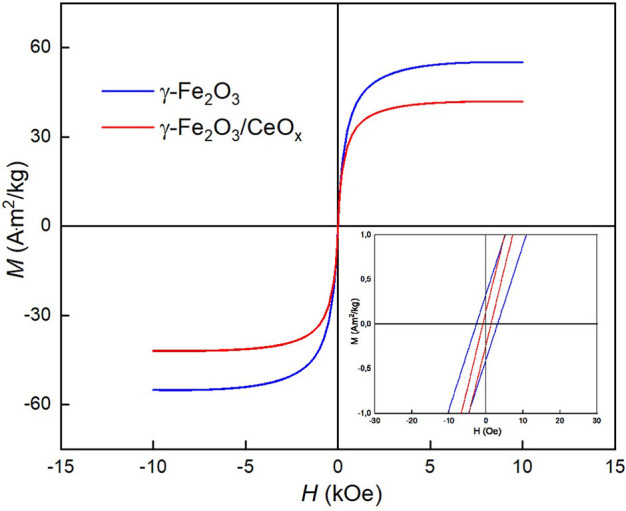
Magnetization hysteresis loop of γ-Fe2O3 (blue) and γ-Fe2O3/CeOx nanoparticles (red) at room temperature; magnified loop is inserted. H, magnetic field; M, magnetization.